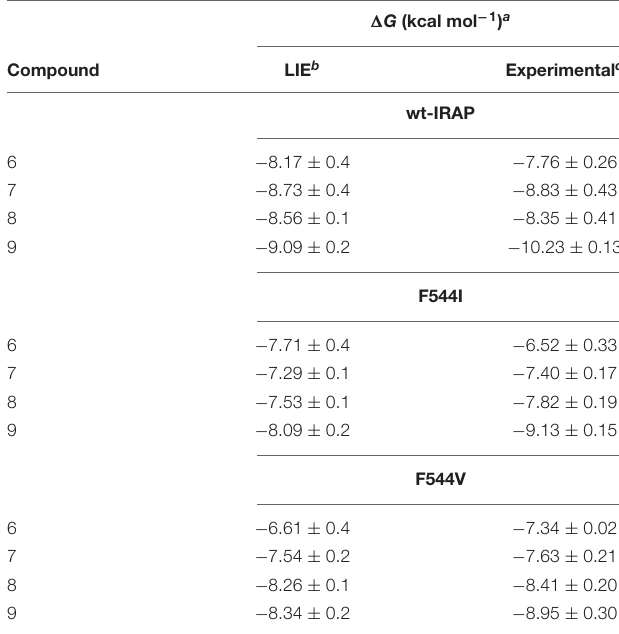
TABLE 2 | LIE calculated and experimentally binding free energies ( (cid:49) G, in kcal/mol) for compounds 6–9 in wild type and mutant